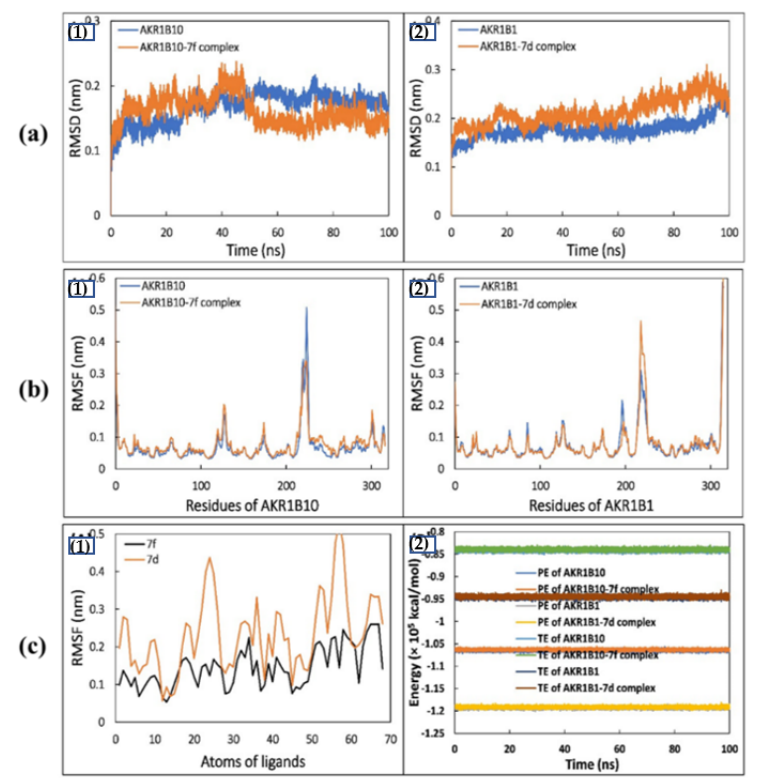
Figure 8. ( a ) (1) RMSD of AKR1B10 backbone and AKR1B10 − 7f complex as the function of time. (2) Figure 8. ( a1 ) RMSD of AKR1B10 backbone and AKR1B10 − 7f complex as the function of time. RMSD of AKR1B1 backbone and AKR1B1 − 7d complex as the function of time. ( b ) (1) RMSF of C α ( a2 ) RMSD of AKR1B1 backbone and AKR1B1 − 7d complex as the function of time. ( b1 ) RMSF atoms of AKR1B10 and AKR1B10 − 7f complex. (2) RMSF of C α atoms of AKR1B1 and AKR1B1 − 7d of C α atoms of AKR1B10 and AKR1B10 − 7f complex. ( b2 ) RMSF of C α atoms of AKR1B1 and complex. ( c ) (1) The average RMSF value of each atom of 7f and 7d when in complexation with AKR1B1 − 7d complex. ( c1 ) The average RMSF value of each atom of 7f and 7d when in complexation AKR1B10 and AKR1B1, respectively. (2) Potential energy and total energy of AKR1B10, AKR1B10 with AKR1B10 and AKR1B1, respectively. ( c2 ) Potential energy and total energy of AKR1B10, − 7f complex, AKR1B1, and AKR1B1 − 7d complex as the function of time. AKR1B10 − 7f complex, AKR1B1, and AKR1B1 − 7d complex as the function of